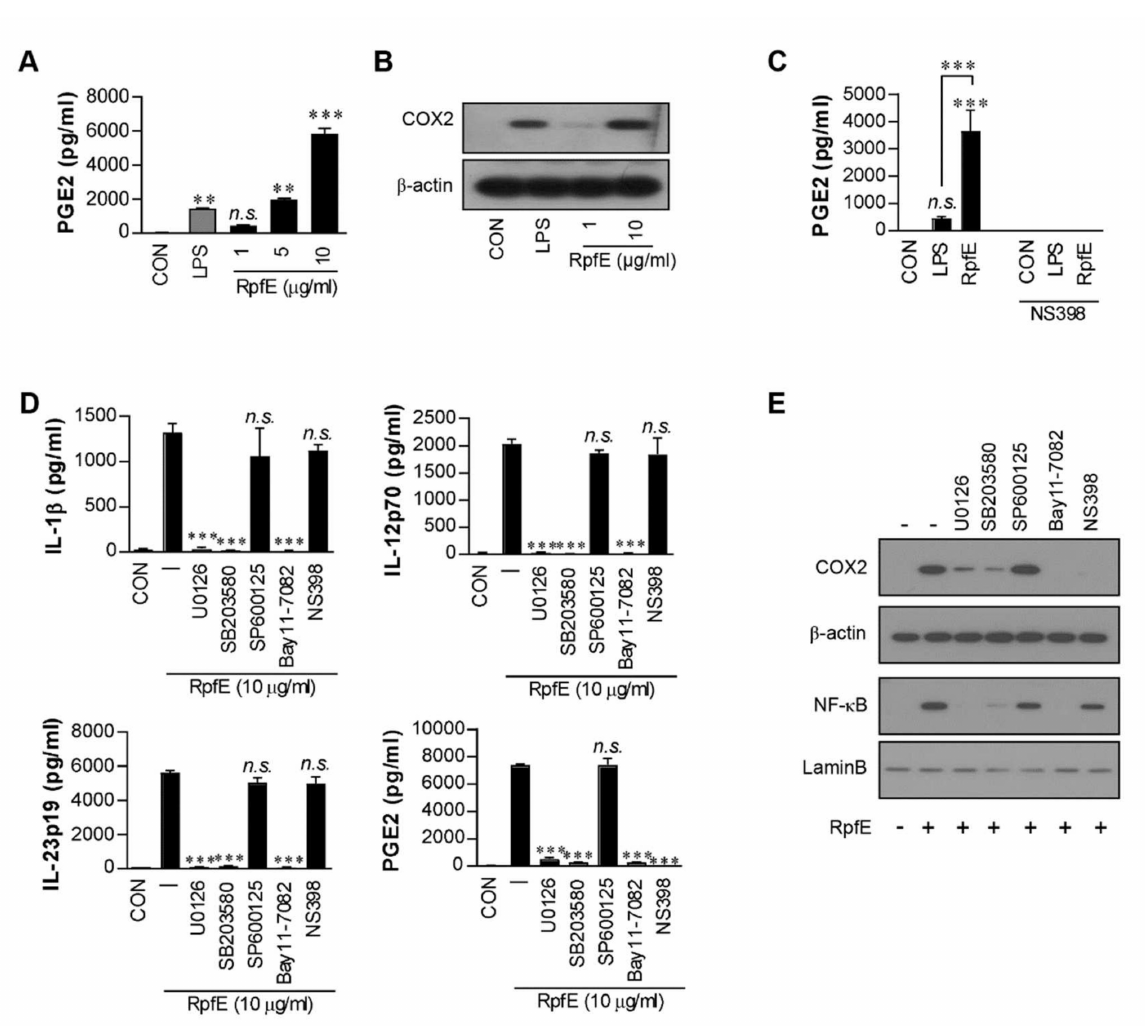
Figure 1. Mycobacterium tuberculosis (Mtb) RpfE produces prostaglandin E2 (PGE2) in activated dendritic cells (DCs) via the MAPK/NF- κ B/COX2 signaling pathway. ( A ) DCs (1 × 10 6 cells/mL) were cultured in the presence of 1, 5, or 10 µ g/mL RpfE or 100 ng/mL LPS for 24 h, and the levels of PGE2 in the culture supernatant were quantified using ELISA. Data are the mean ± SD from three independent experiments; ** p < 0.01 and *** p < 0.001 compared to untreated DCs. n.s. : no significant difference. ( B ) DCs were treated with 1 or 10 µ g/mL RpfE or 100 ng/mL LPS for 4 h. Cell lysates were subjected to SDS-PAGE, and immunoblotting analysis was performed using COX2 antibody. β -actin was used as the loading control for the cytosolic fraction. ( C ) DCs were treated with pharmacological inhibitors of NS398 (COX2 inhibitor, 10 µ M) for 1 h prior to treatment with 10 µ g/mL RpfE or 100 ng/mL LPS for 24 h. The levels of PGE2 in the culture media were determined using ELISA. Data are the mean ± SD from three independent experiments; *** p < 0.001 compared to untreated DCs. n.s. : no significant difference. ( D ) DCs were treated with pharmacological inhibitors of p38 (SB203580, 20 µ M), ERK1/2 (U0126, 10 µ M), JNK (SP600125, 20 µ M), NF- κ B (Bay11-7082, 20 µ M), and NS398 (10 µ M) for 1 h prior to treatment with 10 µ g/mL RpfE for 24 h. The levels of IL-1 β , IL-12p70, IL-23p19, and PGE2 in the culture media were determined using ELISA. Data are the mean ± SD from three independent experiments; *** p < 0.001 compared to RpfE treated DCs. n.s. : no significant difference. ( E ) DCs were treated with pharmacological inhibitors for 1 h prior to treatment with 10 µ g/mL RpfE for 4 h. Cell lysates were subjected to SDS-PAGE, and immunoblotting analysis was performed using COX2 or NF- κ B antibodies. β -actin and Lamin B were used as the loading controls for the cytosolic and nuclear fractions,